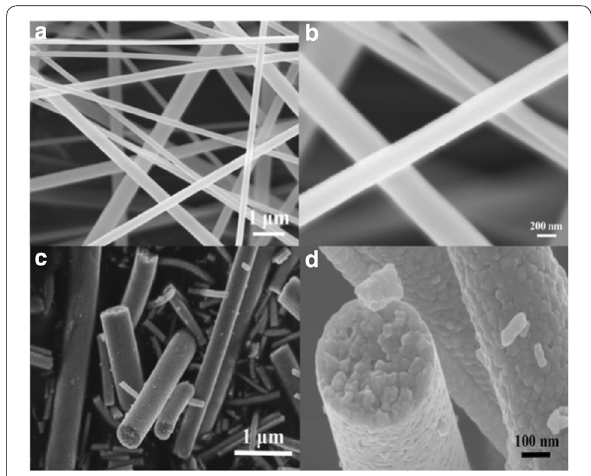
Figure 2 SEM images of the as-spun PVP/TiO 2 composite nanofibers: a the lower magnification and b the higher magnification, and after calcination the TiO 2 nanofibers: c the lower magnification and d the higher magnification